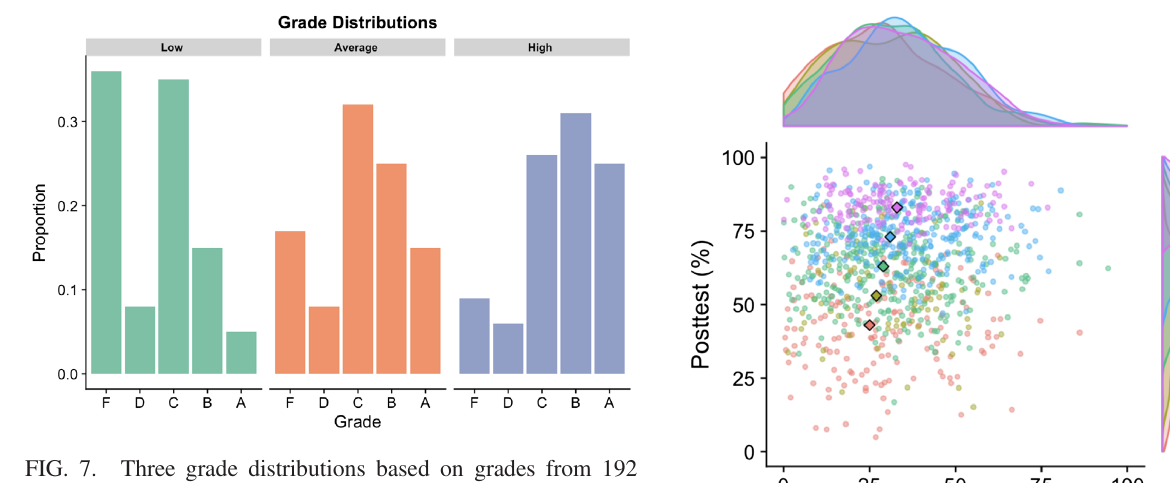
FIG. 7. Three grade distributions based on grades from 192 STEM courses.